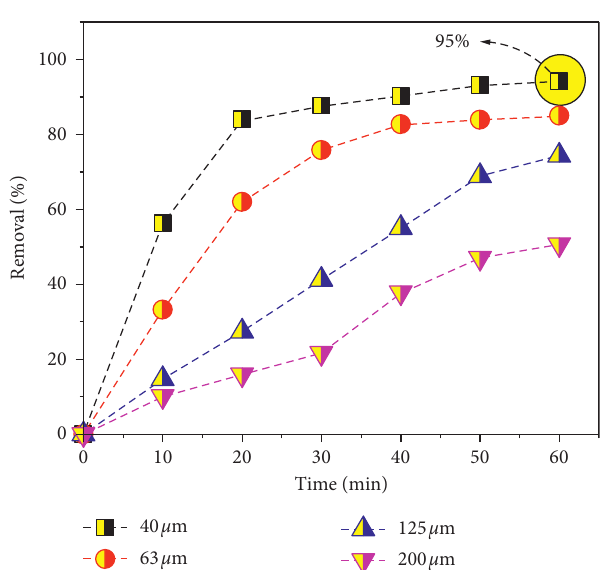
Figure 8: RBB removal at different particle sizes of RDP.